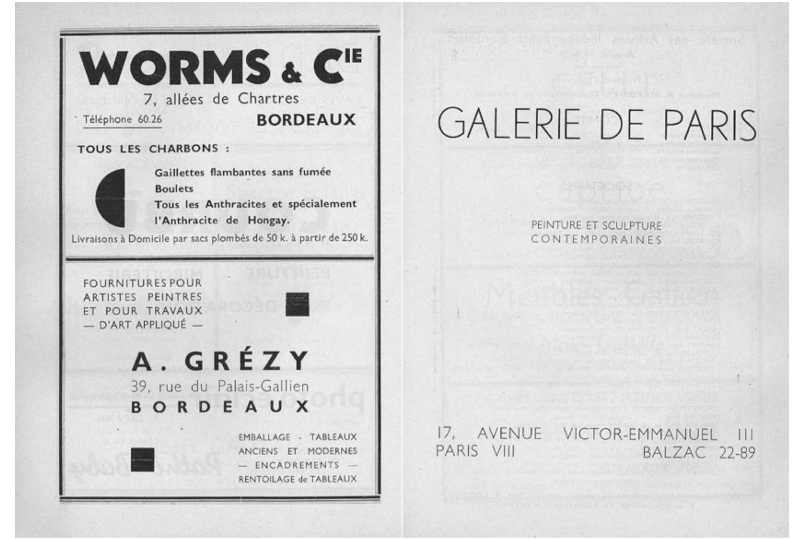
Figure 8. Exhibition catalogue of the SAIB, 1936, pp.